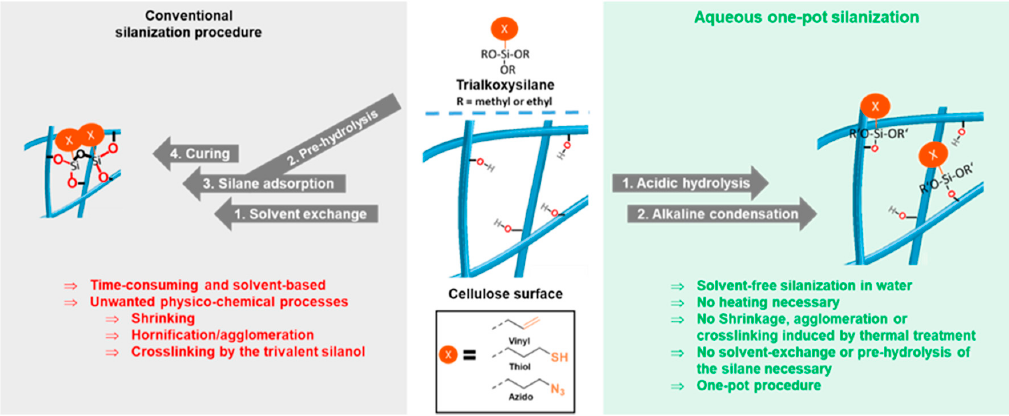
Figure 1. Conventional silanization procedure ( left ) and novel two-step silanization protocol ( right ): First the reaction mixture is acidified with HCl to pre-hydrolyze the alkoxysilane, then NaOH is added to induce condensation in this homogeneous system. Following this protocol, azido, vinyl, and thiol groups were introduced onto never-driedcellulose surfaces.